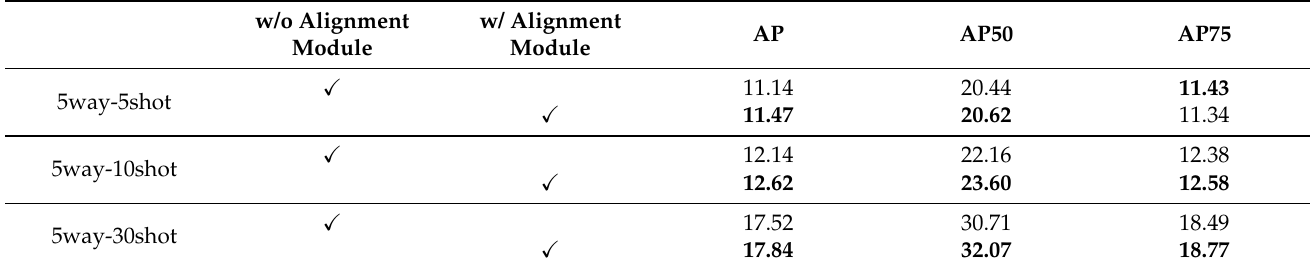
Table 6. The ablation result for Alignment module in Aligned Contrastive Loss.